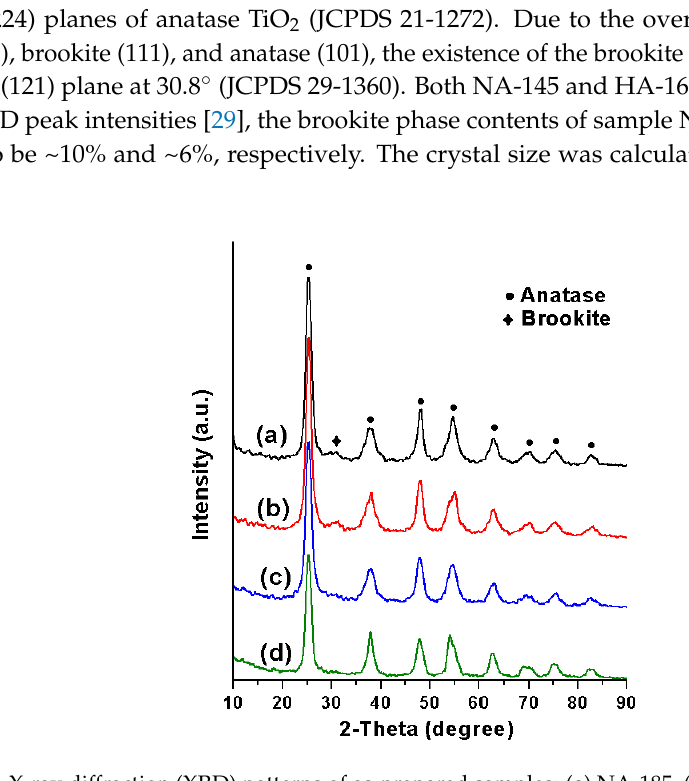
Figure 1. X ‐ ray diffraction (XRD) patterns of as ‐ prepared samples: ( a ) NA ‐ 185, ( b ) NA ‐ 165, Figure 1. X-ray diffraction (XRD) patterns of as-prepared samples: ( a ) NA-185, ( b ) NA-165, ( c ) NA-145, ( c ) NA ‐ 145, ( d ) HA ‐ 165. ( d ) HA-165. Table 1. The characteristics and the apparent first-order rate constant K (min − 1 ) of Table 1. The characteristics and the apparent first ‐ order rate constant K (min − 1 ) of samples.